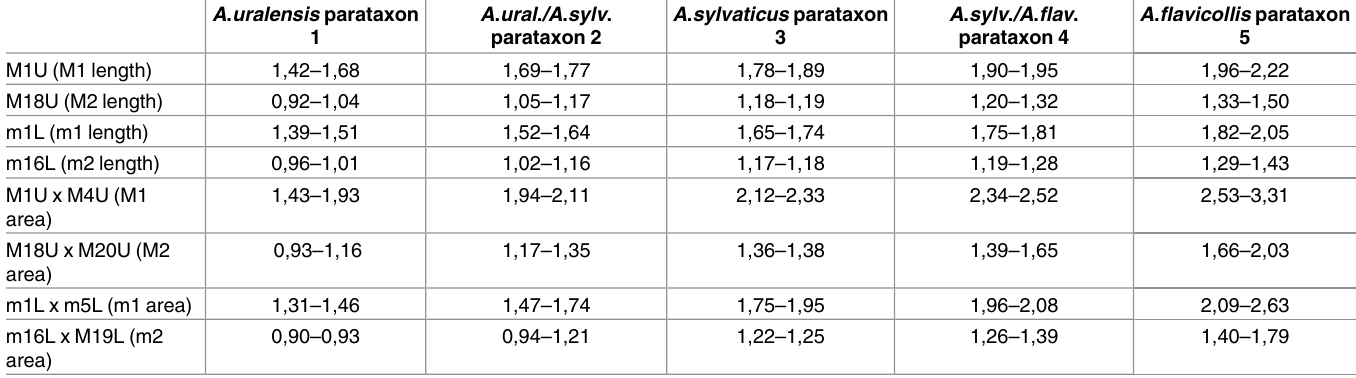
Table 2. The most robust discrimination characters and their variation ranges separating the zones of between-species overlaps (parataxa2 and 4) based on the Recent sample (n = 225 skulls, 889 teeth).